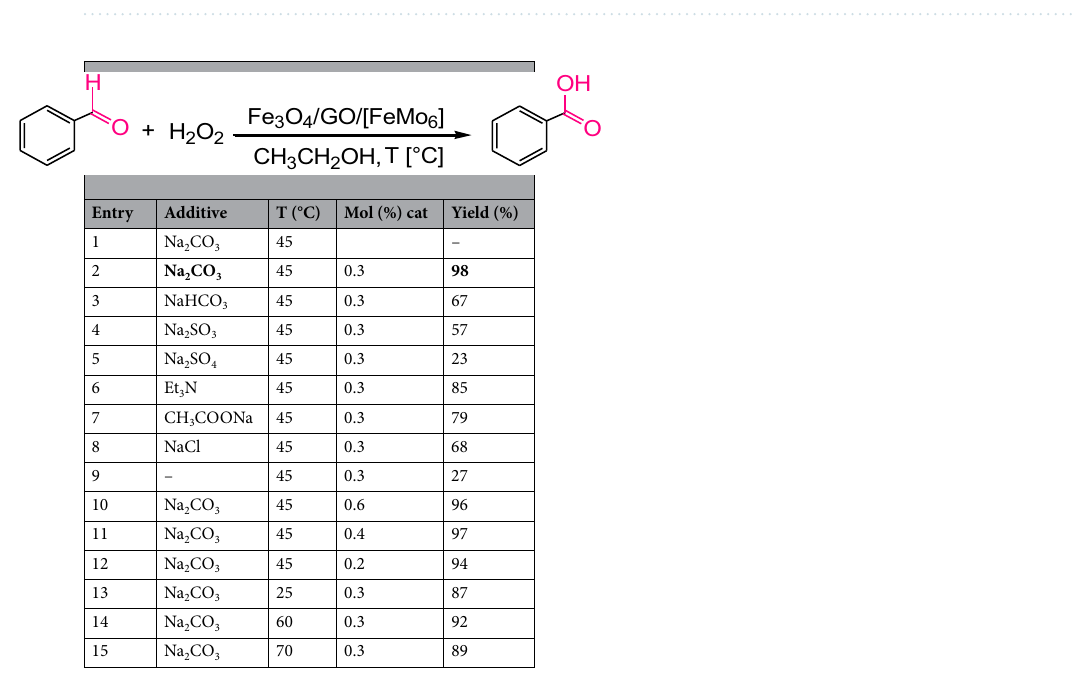
Figure 7. Raman spectra obtained on the GO and Fe 3 O 4 /GO/[FeMo 6 ].